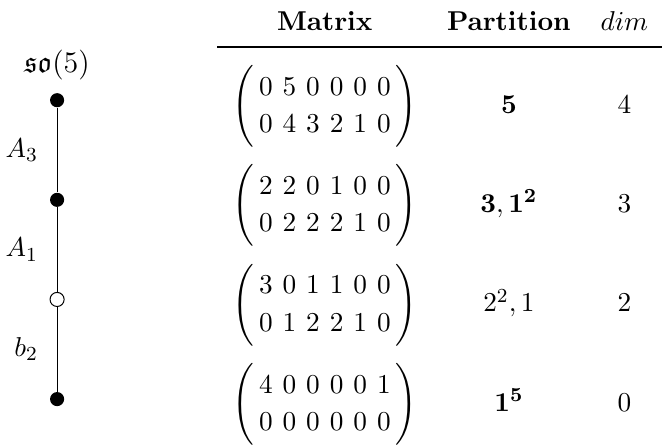
Table 12. Results obtained applying the matrix formalism to so (5).